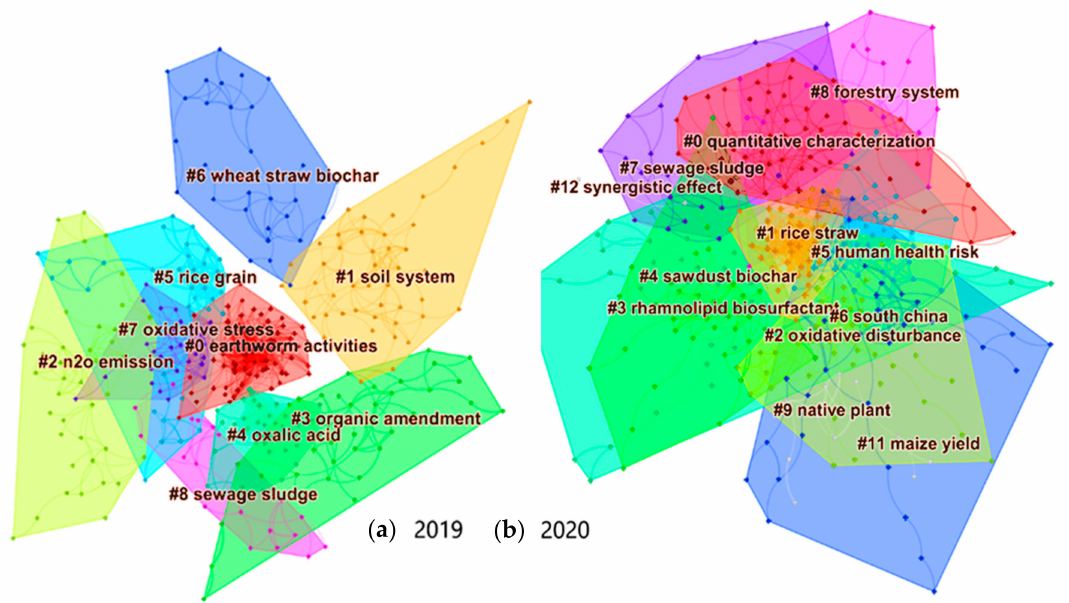
Figure 2. CiteSpace maps, showing the most active (most published papers) sub-fields (clusters) under the Scopus search terms ‘biochar & soil pollution’, for the years: ( a ) 2019 (341 papers); ( b ) 2020 (284 papers so